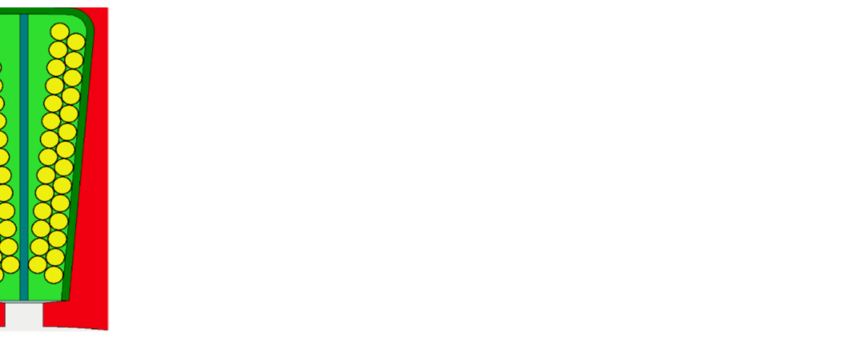
Figure 8. Example of laying the motor cables in individual tubes and assembling them vertically from the winding ends in order to avoid any overlapping.